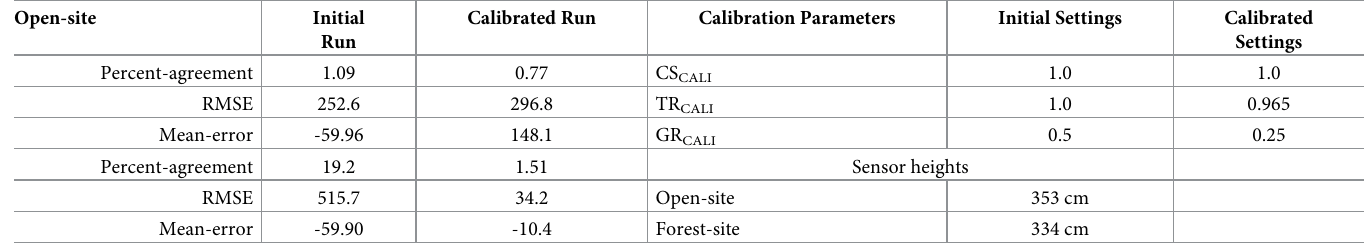
Table 4. Falls Creek parameters, initial results, and calibrated results.